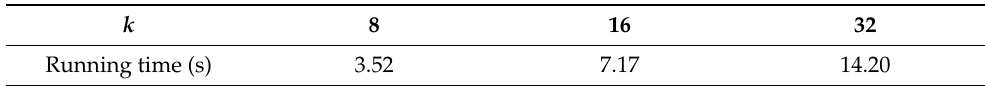
Table 6. Running time of SCP .